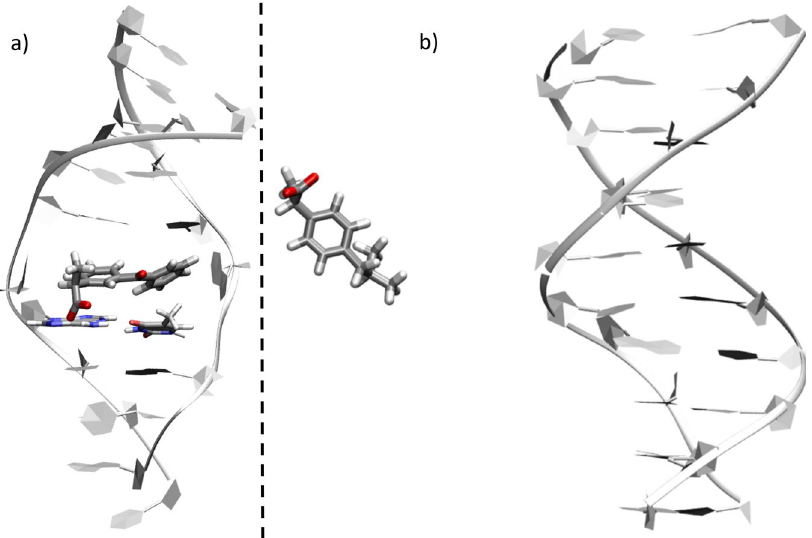
Figure 8. Representative structures extracted from the MD simulation of ketoprofen ( a ) and ibuprofen ( b ) interacting with a B-DNA